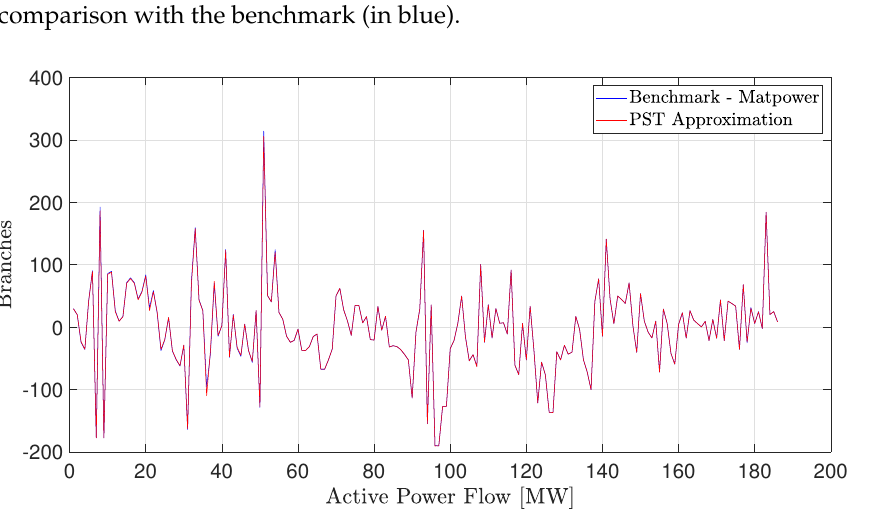
Figure 3. Results of the active power flows approximation with the presence of a PST − Comparison with